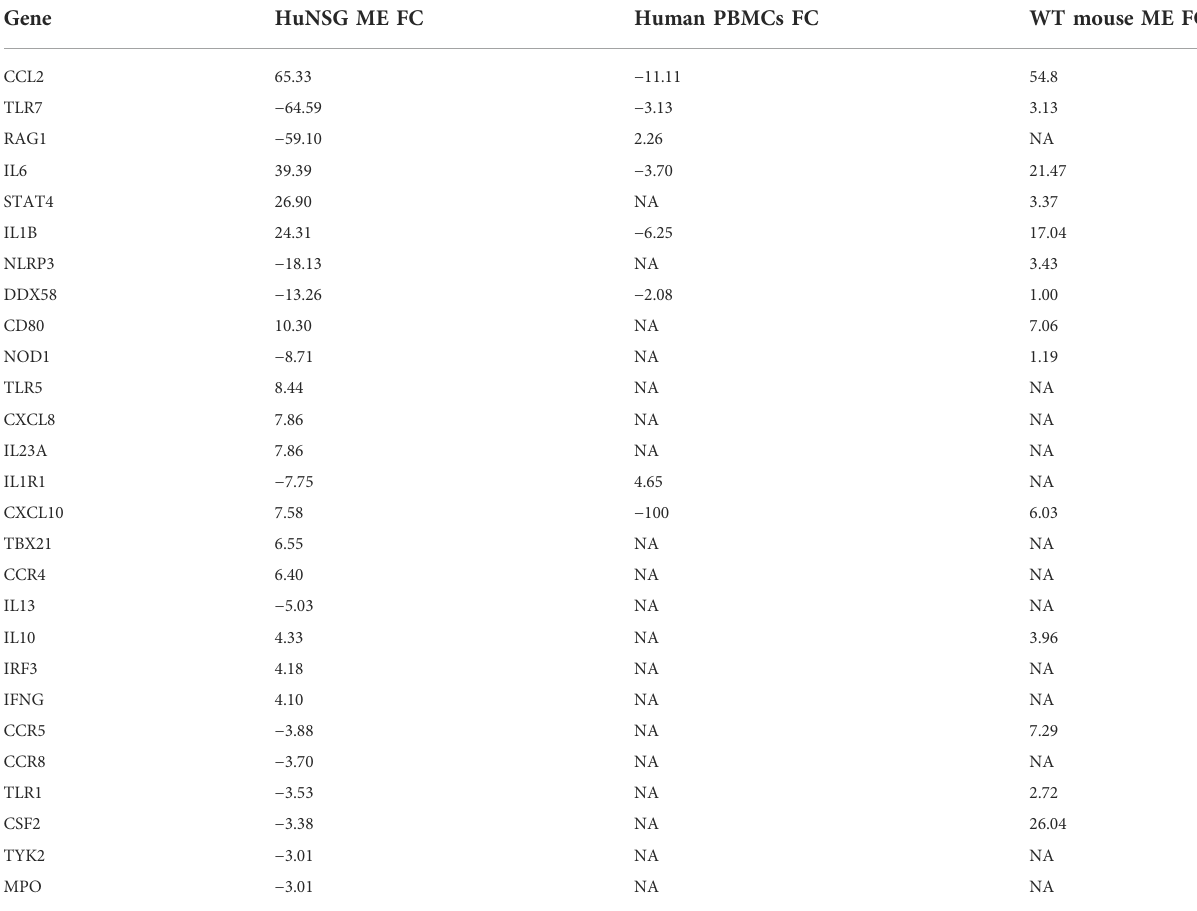
TABLE 2 Comparison of human genes with a > 3 Fold difference in the middle ear of huNSG mice at 48 h post NTHi infection, with those same gene expression from WT mice (Hernandez et al., 2015) at same time, and human PBMCs isolated from pediatric OM patients (Liu et al., 2013). (FC, fold change; NA, data not available, positive values indicate up-regulation and negative